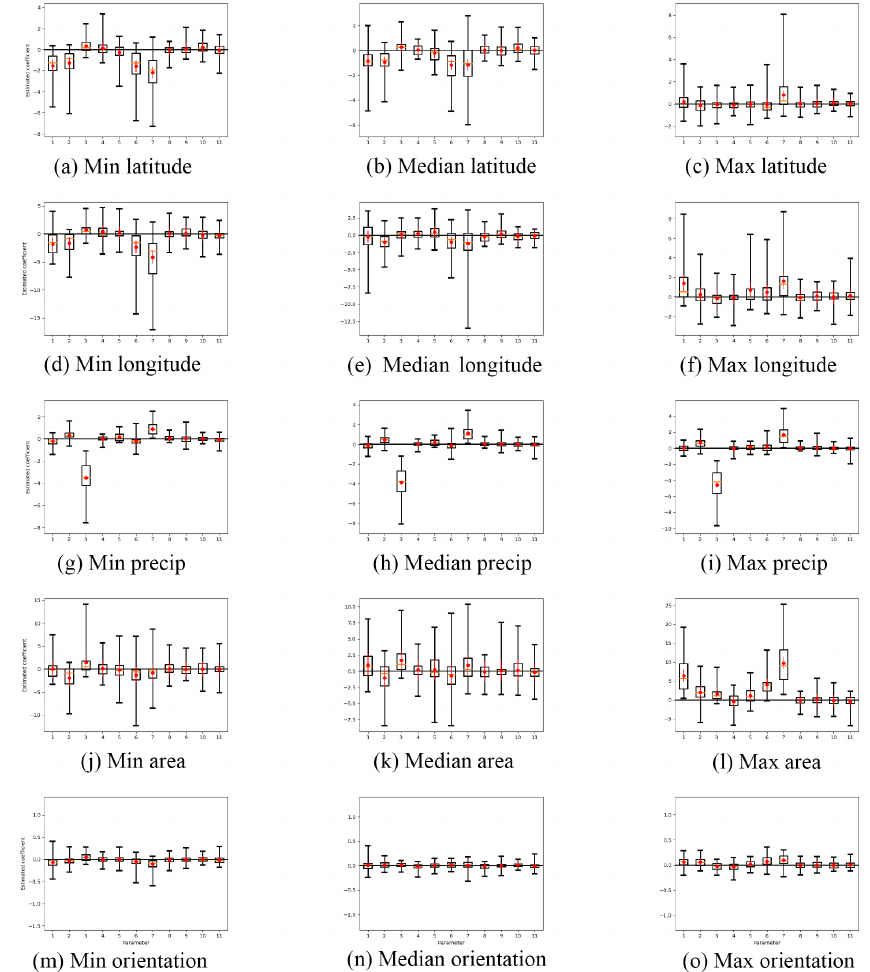
Figure 4. Estimated MMR coefficients (i.e., the sensitivity of the model parameters) on three summary measures (minimum, median, maxi- mum) of different cluster features (latitude, longitude, amount of precipitation, and area and orientation of clusters). Eccentricity is not shown (see text). The red symbols are 95% simultaneous CIs. The clustering is done with DBSCAN with (cid:15) = 2